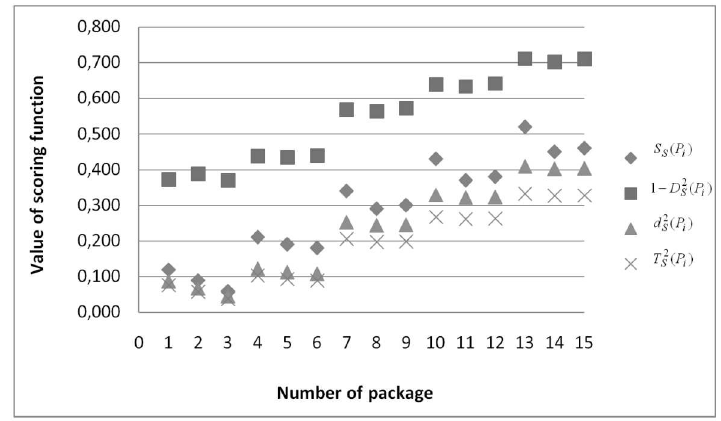
Figure 8. The scoring systems for the Seller – an